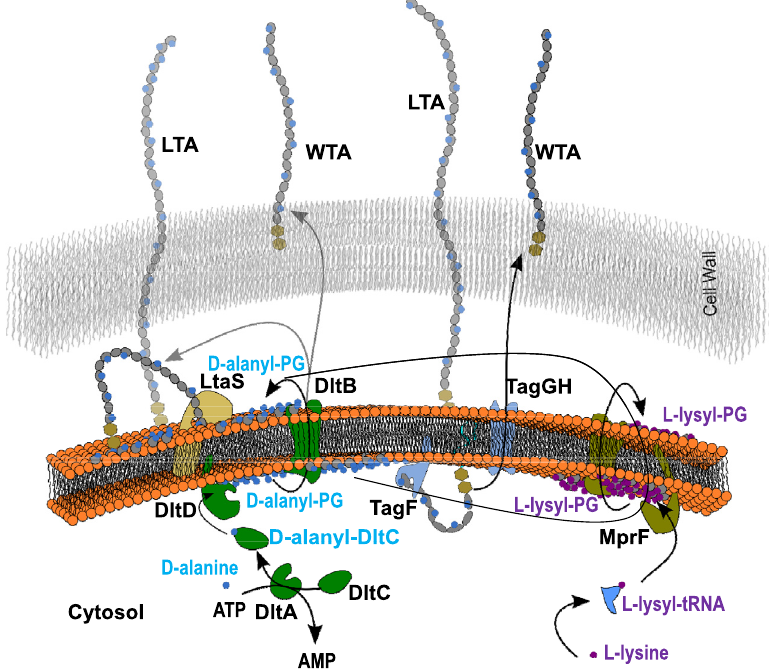
Figure 10. Possible D-alanylation pathways of lipo- and wall-teichoic acids. Arrows depict either transport or transfer processes. The dihexosyl parts of teichoic acids are shown as twin hexagons. The head group of phosphatidylglycerol and repeating glycerolphosphate units in teichoic acids are shown in grey circle and ellipse,